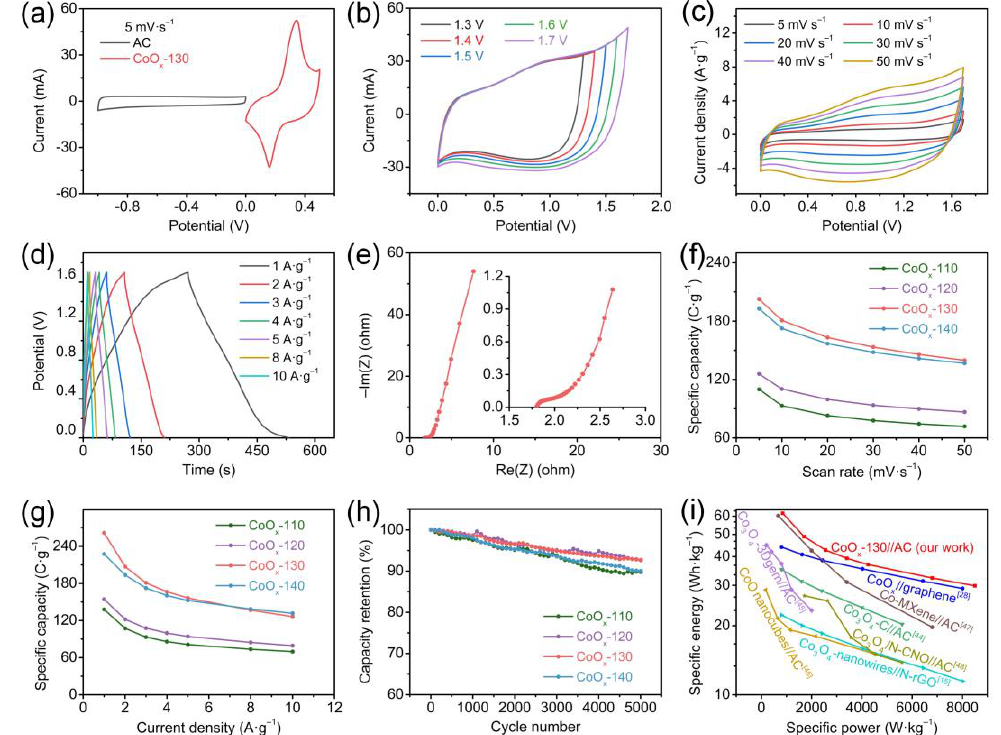
Figure 6. ( a ) The window match of CoO x -130 (red) and AC (black); ( b ) CV curves at various potential windows at 50 mV s −1 ; ( c ) CV curves at various scan rates, ( d ) GCD curves at various current densities, and ( e ) Nyquist plot of the CoO x -130//AC HSC; ( f ) specific capacities at different scan rates, ( g ) specific capacities at different current densities, and ( h ) cycling performance of the CoO x //AC HSCs; ( i ) Ragone plots for the CoO x -130//AC HSC. Cyclic performance is a critical parameter to evaluate the practicability of the